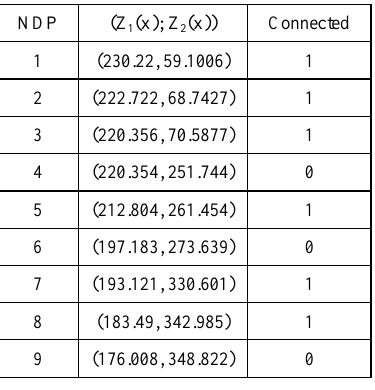
Table 2. Set of all nondominated frontiers of example